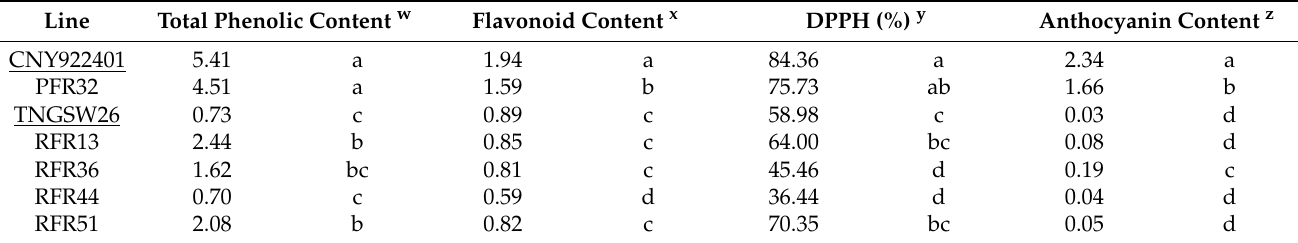
Table 3. Total phenolic content, flavonoid content, DPPH scavenging activity, and anthocyanin content of the seven lines, including recurrent parents, CNY922401, and TNGSW26 in